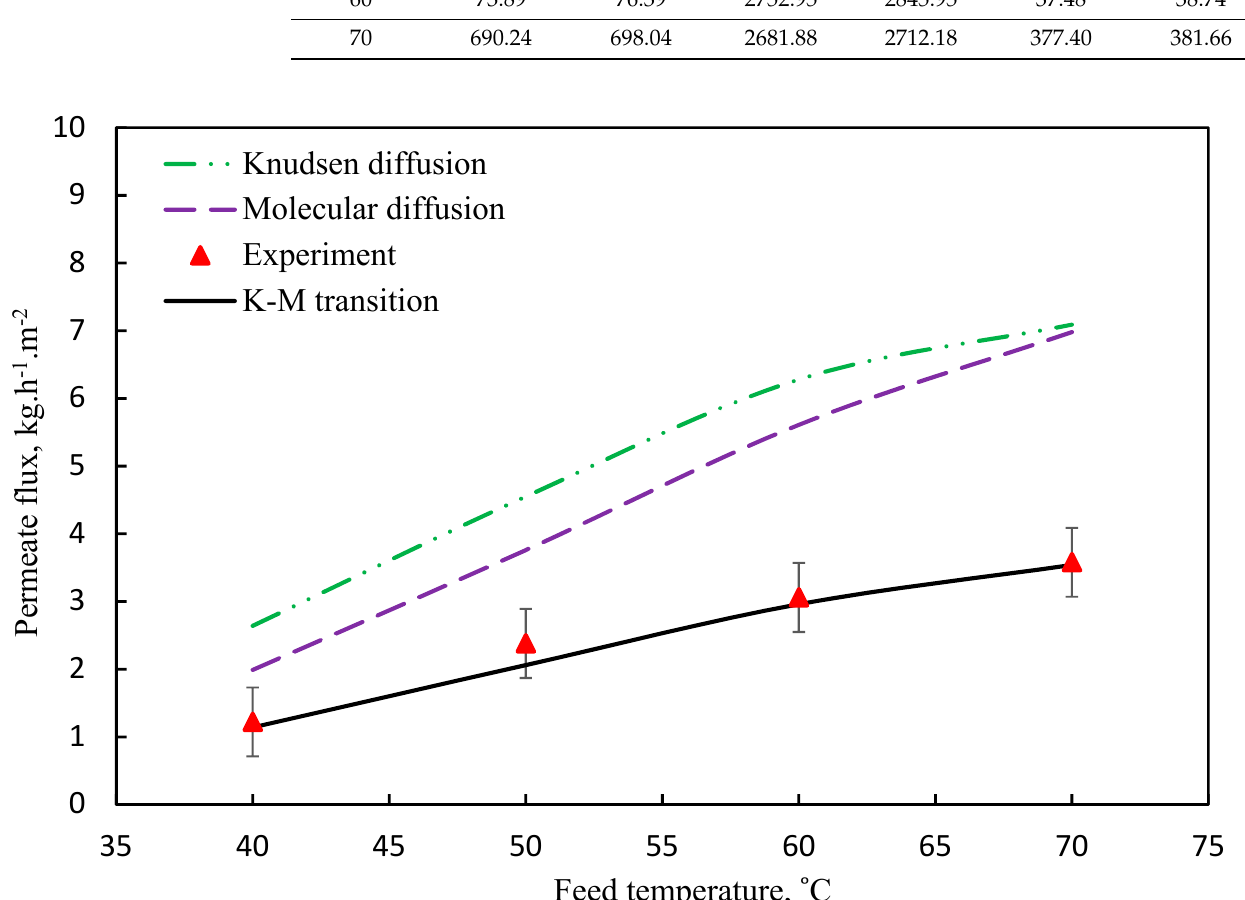
Figure 5. Pure water flux versus feed temperature at m f = 60 L/h and P = 1 bar (K m = 0.38 kg/m (cid:2870) ∙ h ∙ Pa ) Table 7. The influence of temperatures on mass transport resistances.